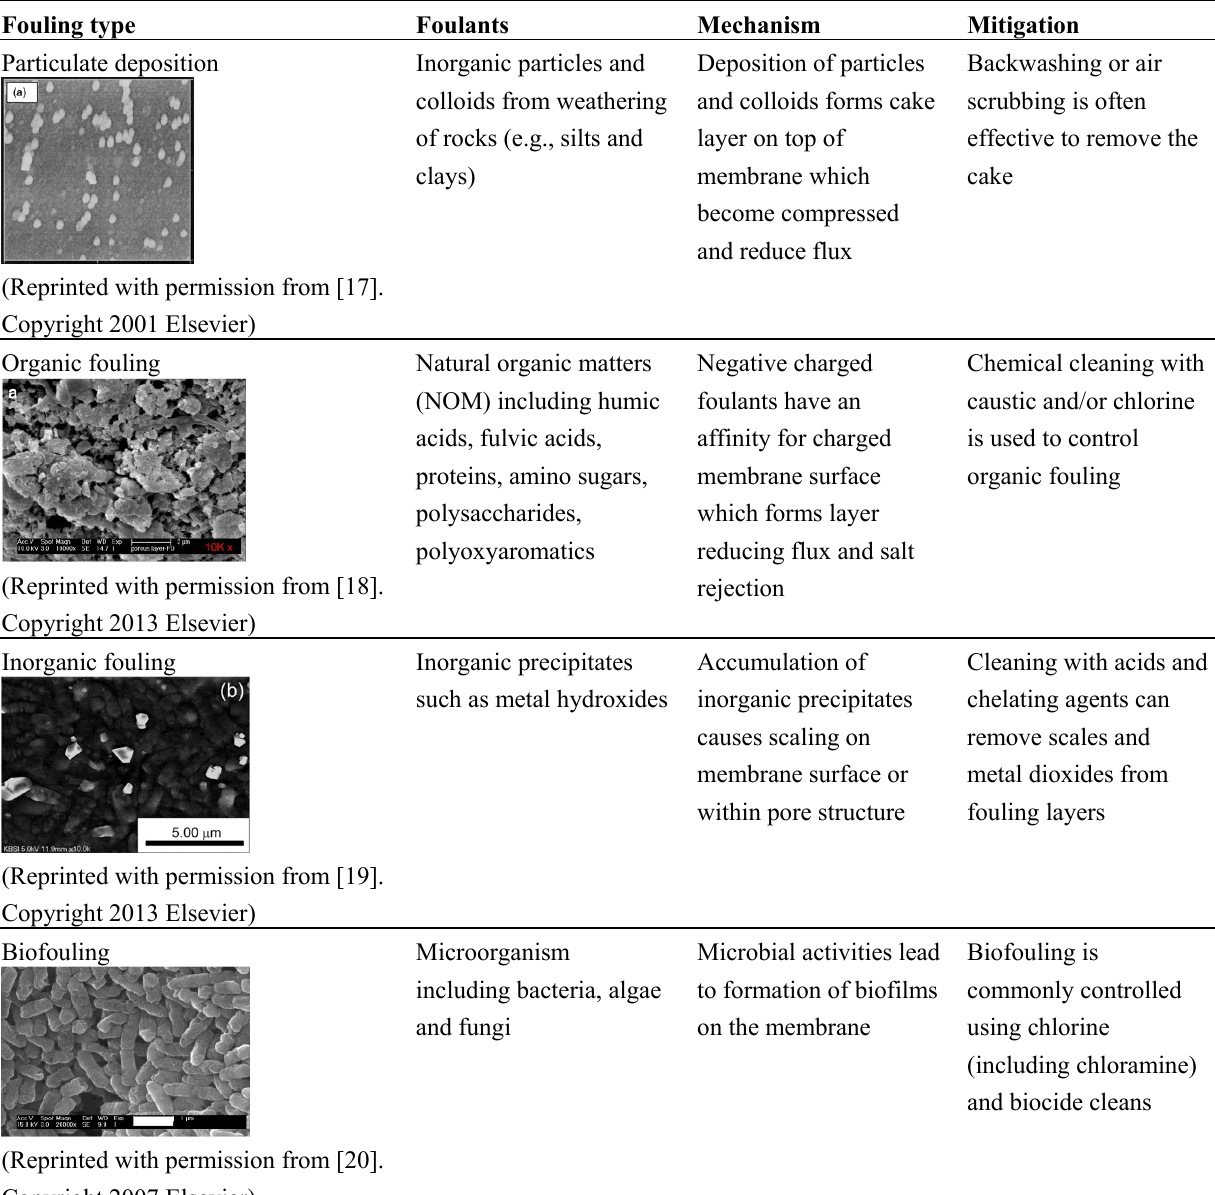
Table 1. Properties of various fouling types